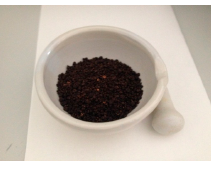
Figure 1. Wet pomace.